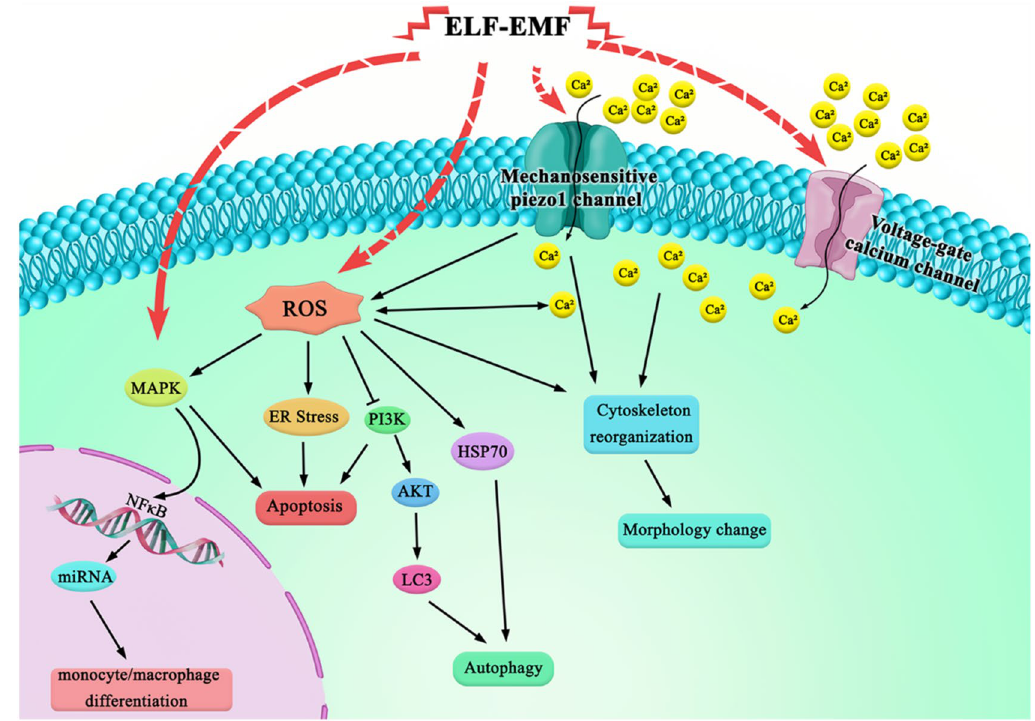
Figure 14. Effect of ELF-EMF on the cell responses. Diagram showing the possible signaling pathways activated by